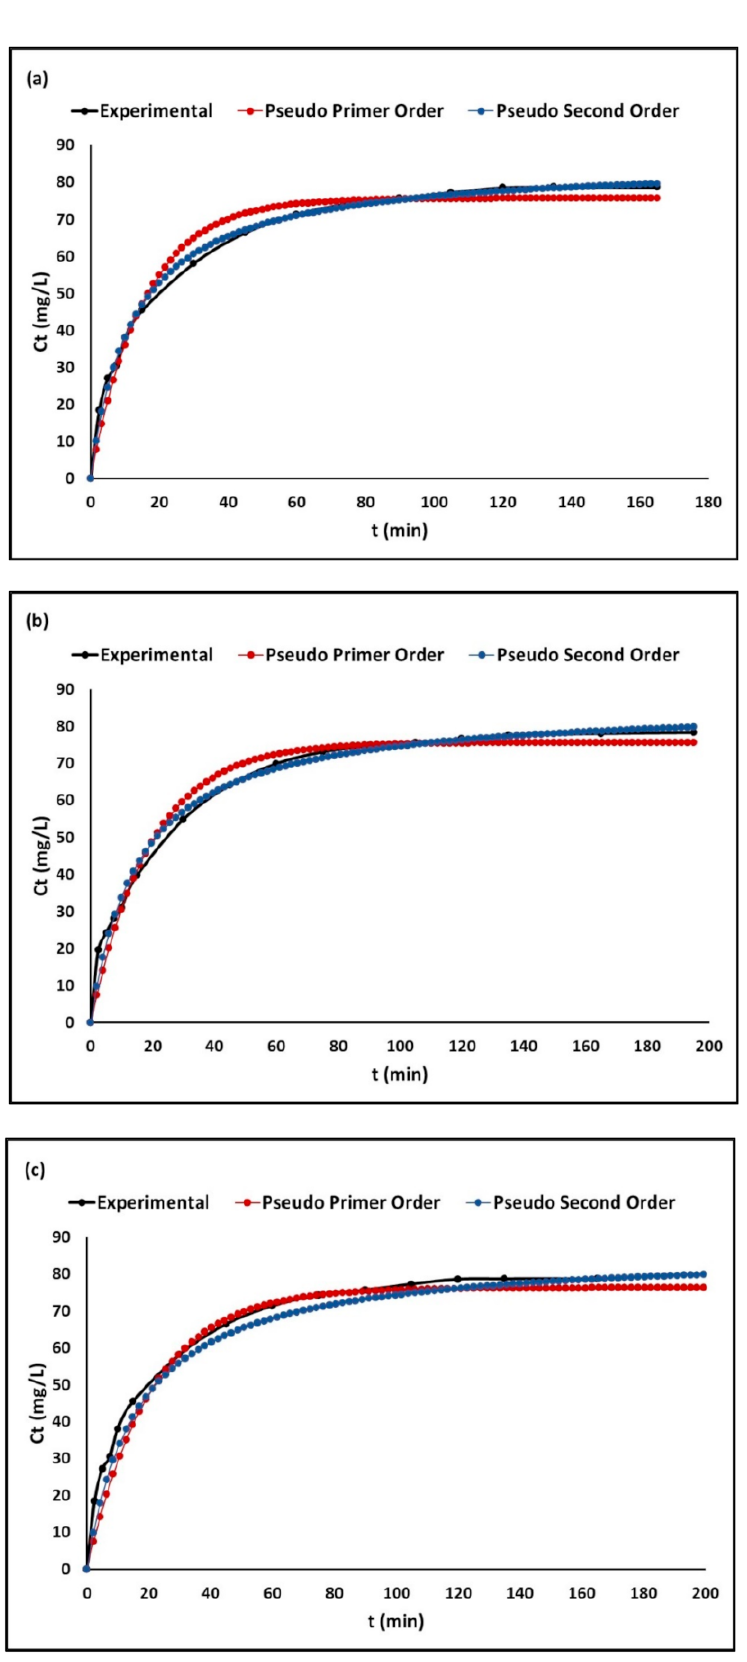
Figure 8. Adsorption kinetics of ( a ) DE, ( b ) ZTO/La-DE, and ( c )